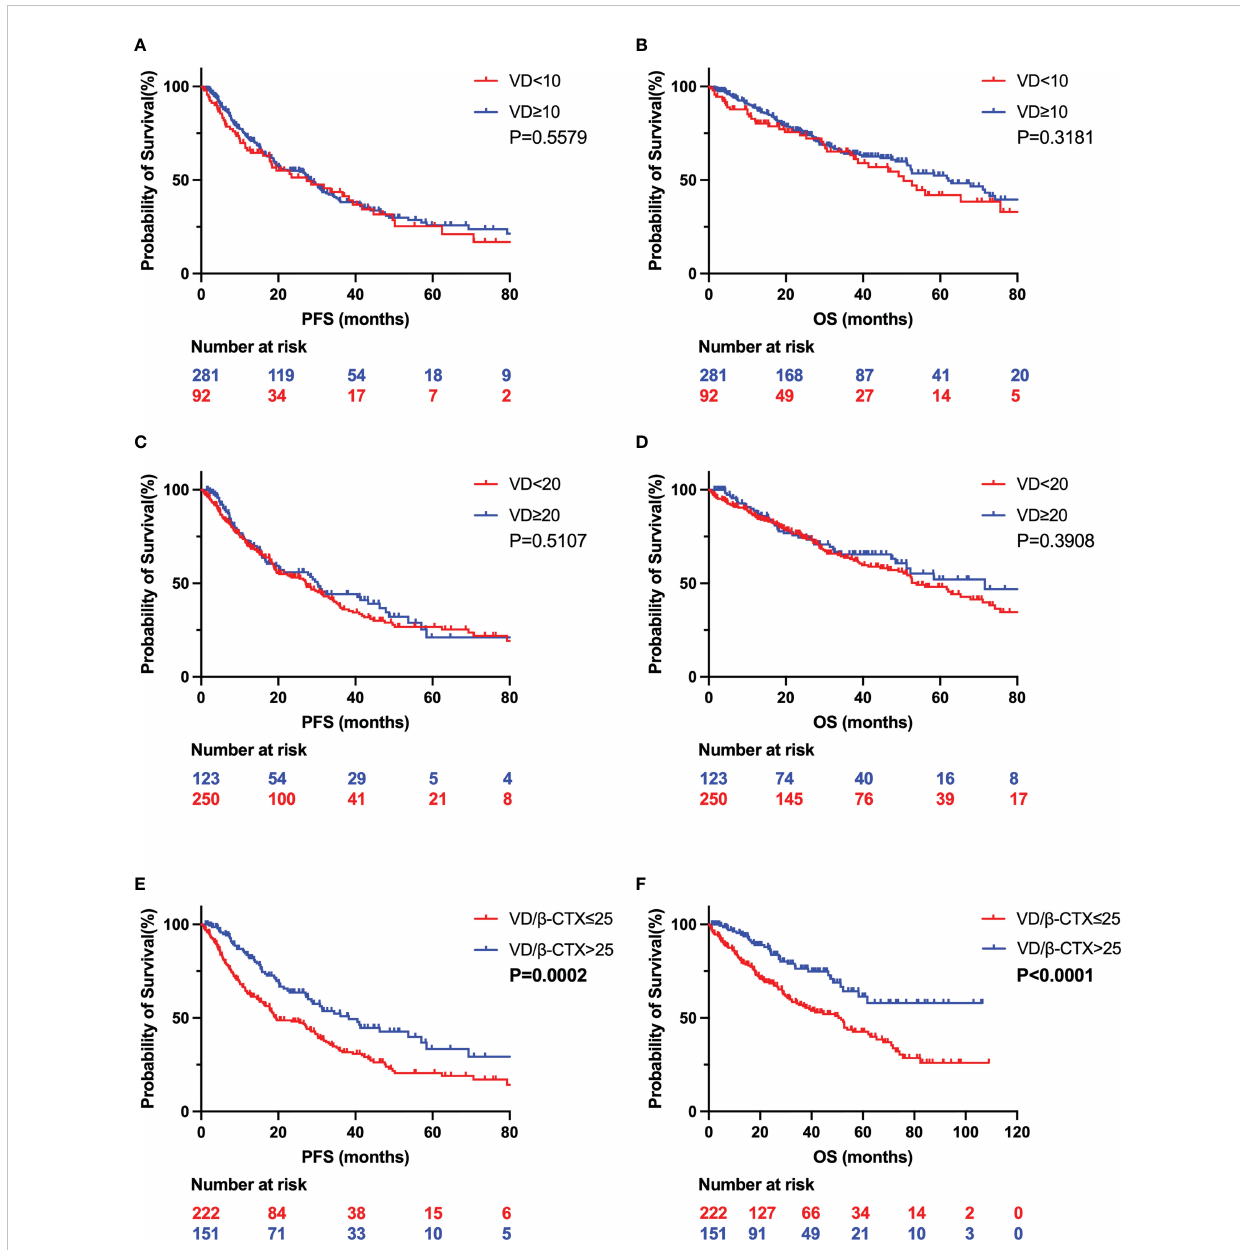
FIGURE 4 Kaplan Meier curves depicting outcomes of patients with values of Vitamin D and VD/ b -CTX. The PFS (A) and OS (B) of the two groups divide by vitamin D levels of 10ng/ml. The PFS (C) and OS (D) of the two groups divide by vitamin D levels of 20ng/ml. The PFS (E) and OS (F) of the two groups divide by VD/ b -CTX value of 25. VD, vitamin D; PFS, progression-free survival; OS, overall survival; b -CTX, bone resorption C-terminal